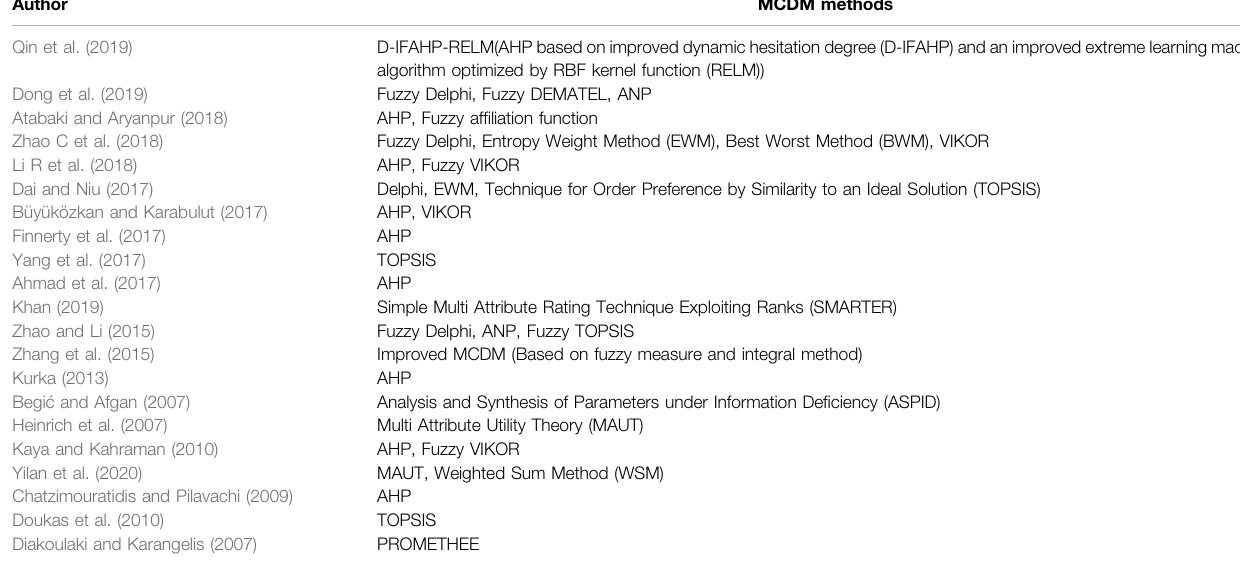
TABLE 13 | Summary of the use of MCDM